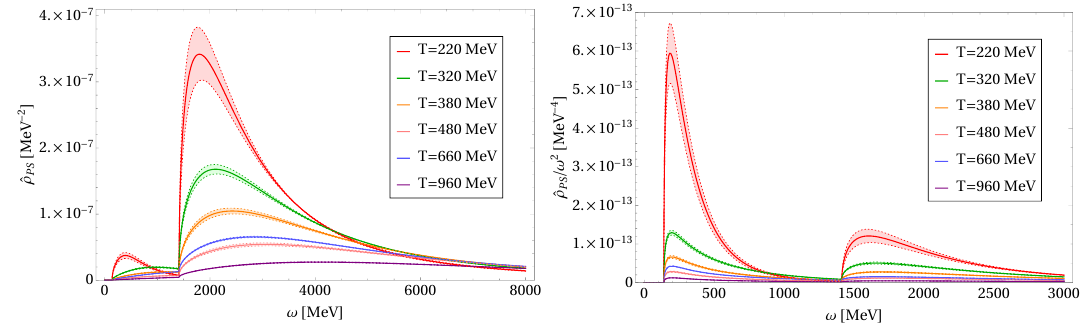
Figure 2 . The unit-normalised pseudo-scalar spectral function ˆ ρ PS ( ω ) (left), and rescaled expres- sion ˆ ρ PS ( ω ) /ω 2 (right), at different temperatures for m π = 140 MeV. The coloured bands indicate the 1 σ